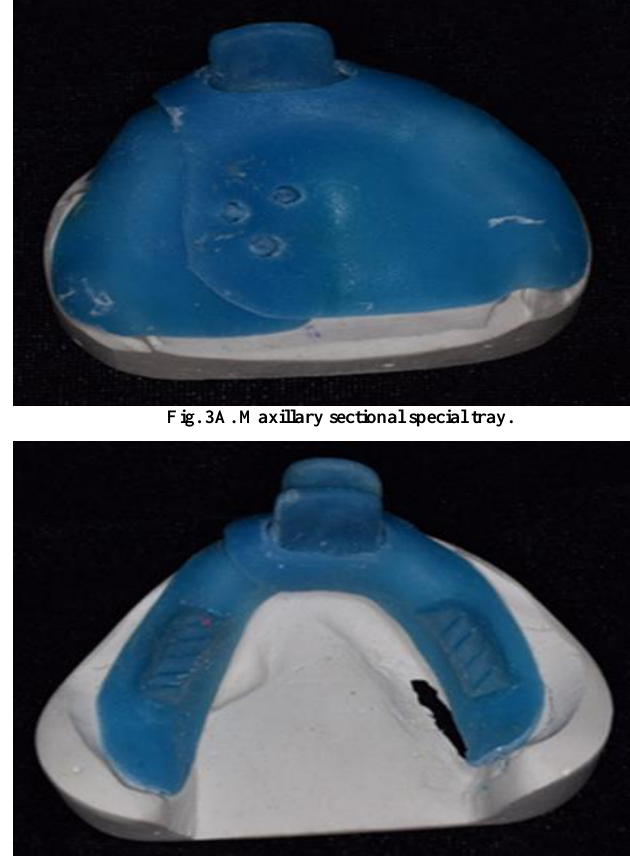
Fig. 3B. Mandibular sectional special tray.